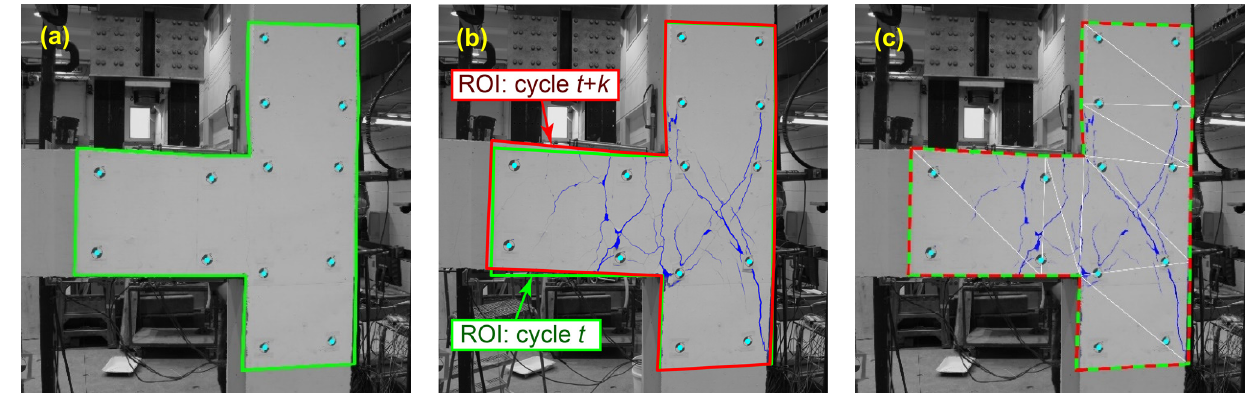
Figure 14. Process of mapping crack masks from cycle t + k onto cycle t : ( a ) image of cycle t with its ROI shown in green, ( b ) image and crack mask of cycle t + k with its ROI shown in red, and ( c ) transformed crack mask of cycle t + k overlayed on the image of cycle t .